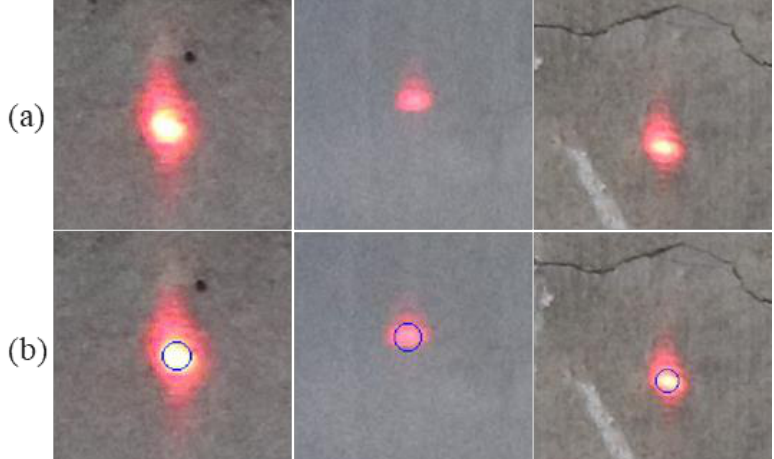
Figure 7. Laser point center recognition: ( a ) original image of laser measuring point; ( b ) identified center by Hough transform. center by Hough